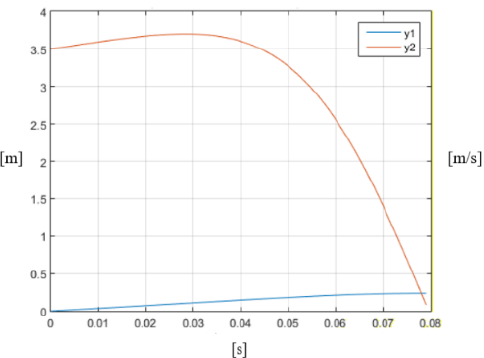
Figure 14. Displacement (blue line) and velocity of the buffer (orange line) at an operating temperature of − 60 ◦ C, an impact speed of v 0 = 3.5 m/s, and η CT = 0.7. The displacement and velocity of the buffer at different operating temperatures ( − 60 ◦ C and 15 ◦ C) and different impact speeds ( v 0 = 1.15 m/s and v 0 = 3.5 m/s) are presented in Figure 15. By reducing